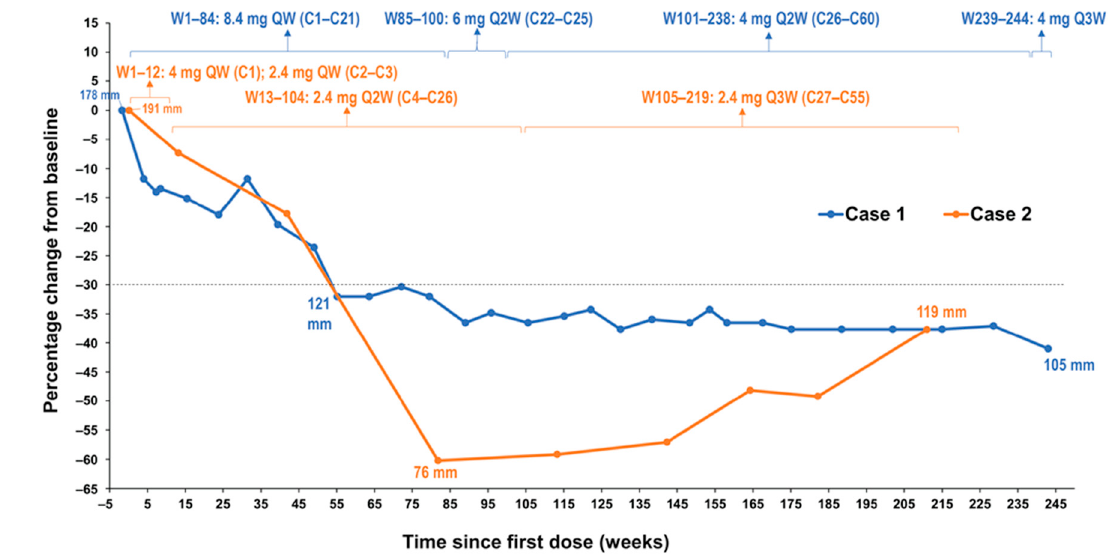
Figure 1. Change in desmoid tumor size from baseline in both patients by RECIST v1.1. Notes: Dotted line denotes change from baseline of 30%. Abbreviations: C, cycle; QW, once weekly; Q2W, once every 2 weeks; Q3W, once every3 weeks; Q4W, once every 4 weeks; W, week; RECIST, Response Evaluation Criteria in Solid Tumors.